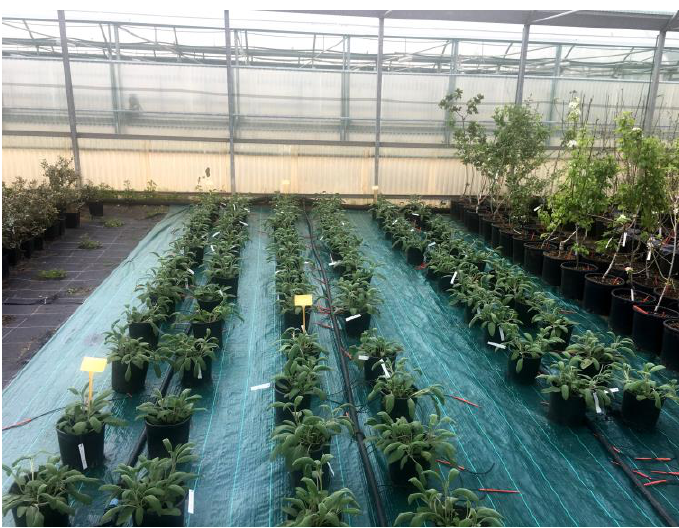
Figure 1. Potted sage plants grown with four different substrates inside the greenhouse.